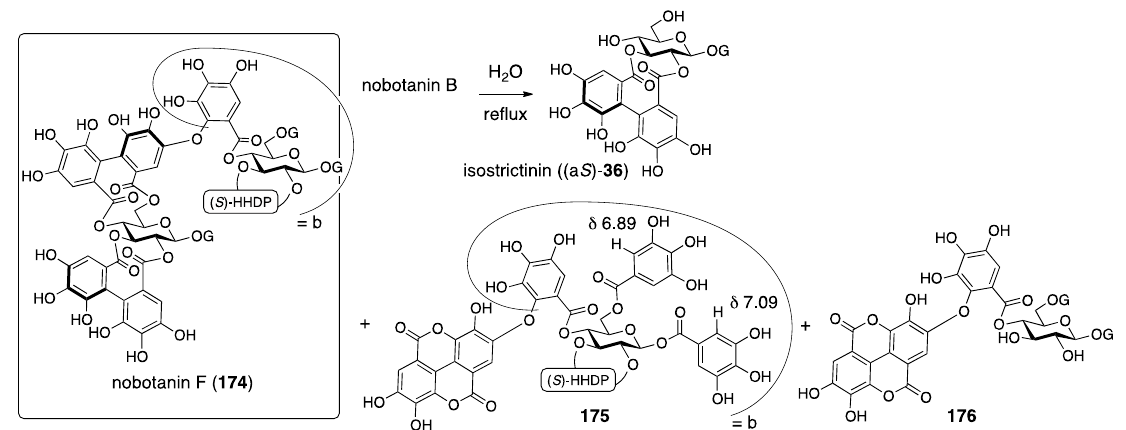
a mark. The usage is the same in the following figures.